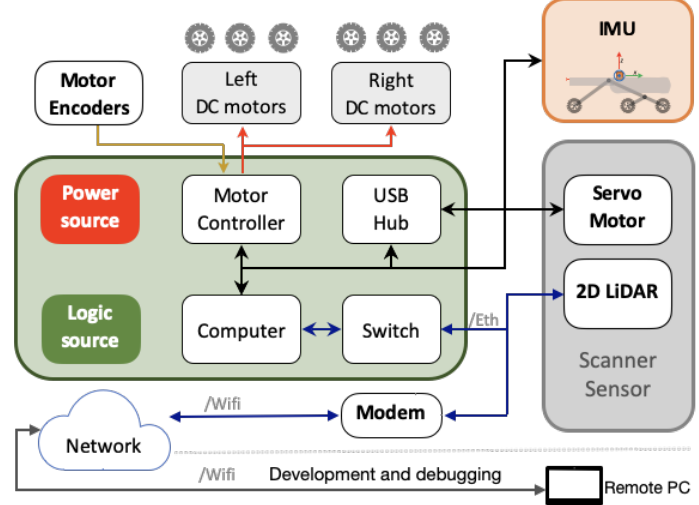
Figure 1. Functional diagram of the 3D mapping